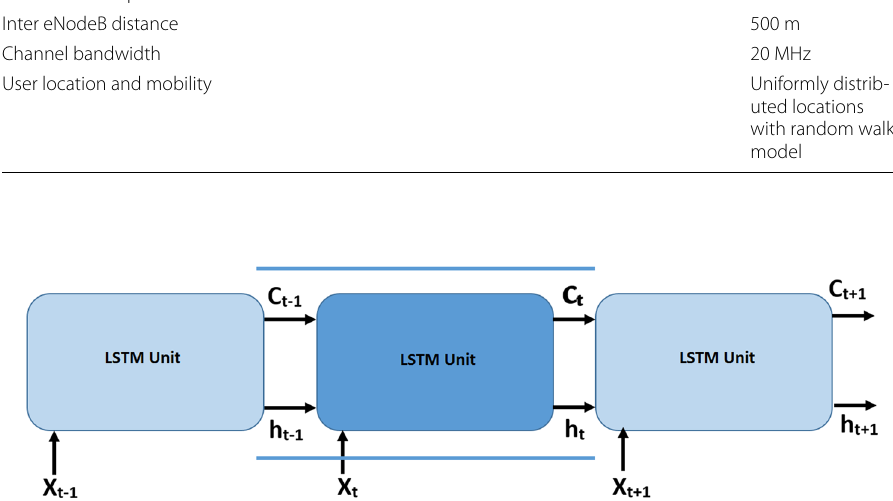
Fig. 1 Repetitive architecture of LSTM units in time